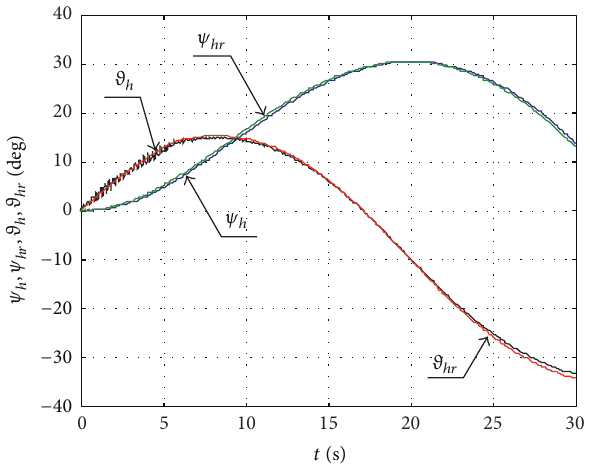
and 𝑀 for in ex